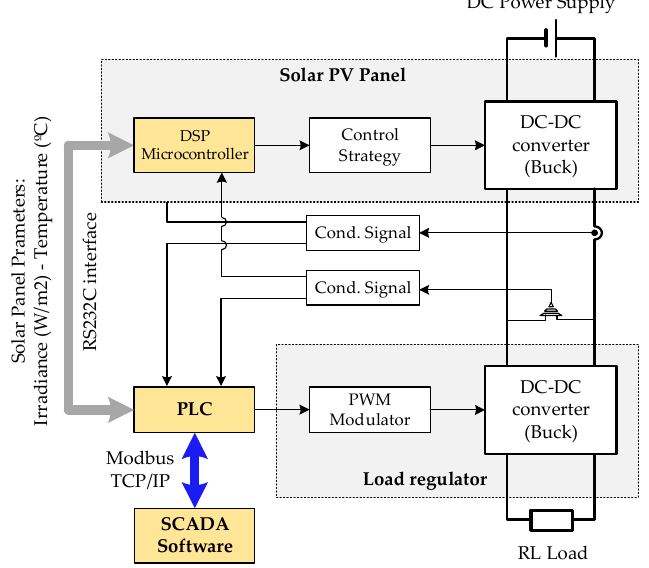
Figure 2. General block diagram of test panel mode (mode I).